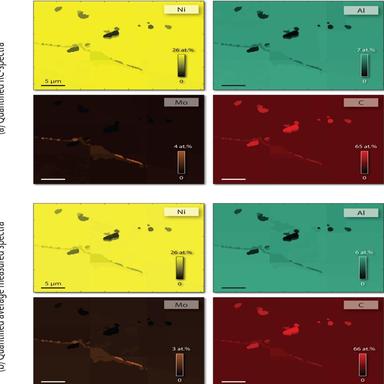
Chemical maps (at.%) of quantified RC-spectra. Only Ni, Al, Mo and C are shown for brevity. This analysis was performed with variance tolerance, t, of 0.2% and EBSD weighting, w, of 1. Maps are shown for directly quantified RC-spectra (a) and average spectra assigned to the same given label (b).